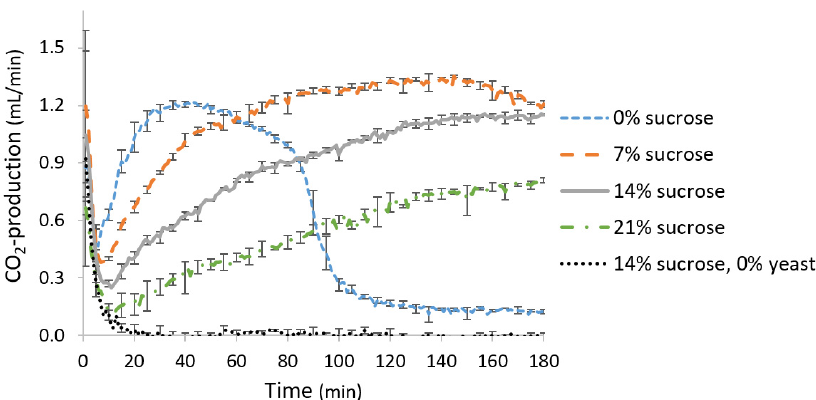
Figure 4. CO 2 production rate (mL/min) in 10 g flour dough samples with 8% yeast and 0, 7, 14 and 21% sucrose and samples with 0% yeast and 14% sucrose as a function of time (min) at 30 °C. Vertical bars represent standard deviations of triplicate measurements.